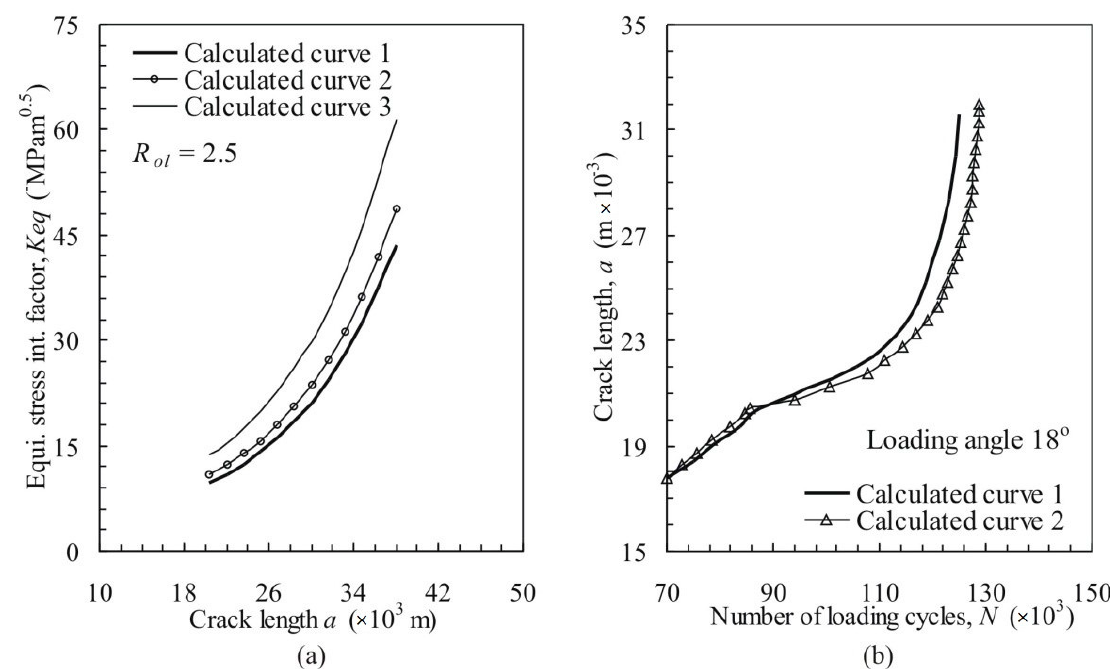
Figure 6. Fatigue resistance analysis: ( a ) K eq versus a (1 − φ = 18°, 2 − φ = 36°, 3 − φ = 54°), calculated curves from the present work, and ( b ) a versus N ( φ = 18°), 1—calculated curve from the present work, 2—calculated curve reported by Mohanty et al. [19].